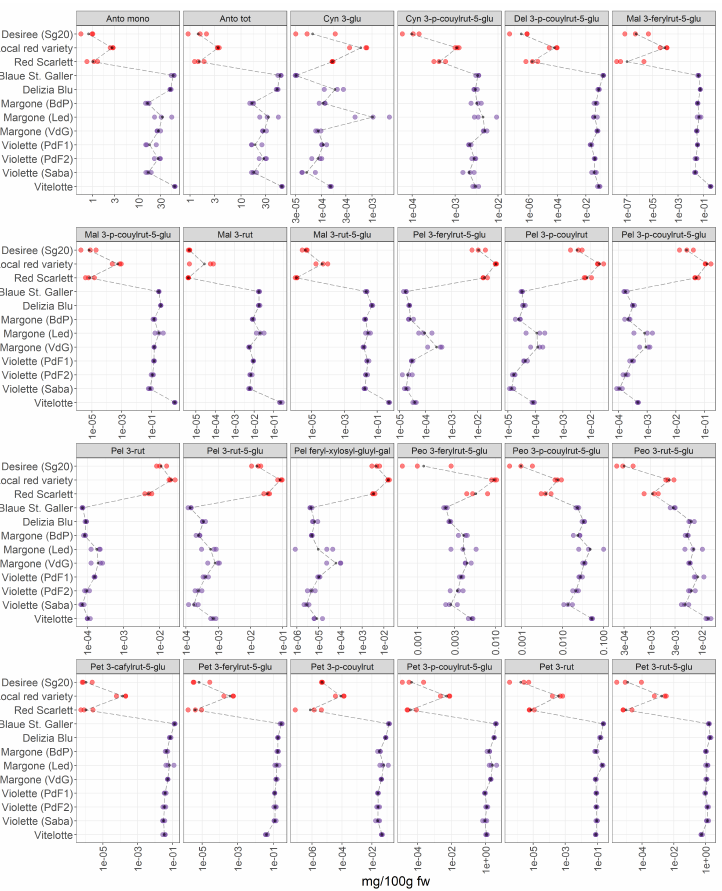
Figure 6. Results of pH differential spectrophotometric method (Anto mono and Anto tot) and 22 single anthocyanins in 12 potato pigmented samples organized in two groups (red-skinned and purple-fleshed); three biological replicates for each sample were analyzed. The black points represented the averages for each analyte calculated on three biological replicates. The black long dash lines showed the concentration trends amongst all the potato groups. The concentrations were transformed in a log-10-scale. fw = fresh weight. Acronyms were reported in Table S2. For detailed information about potato varieties see Table